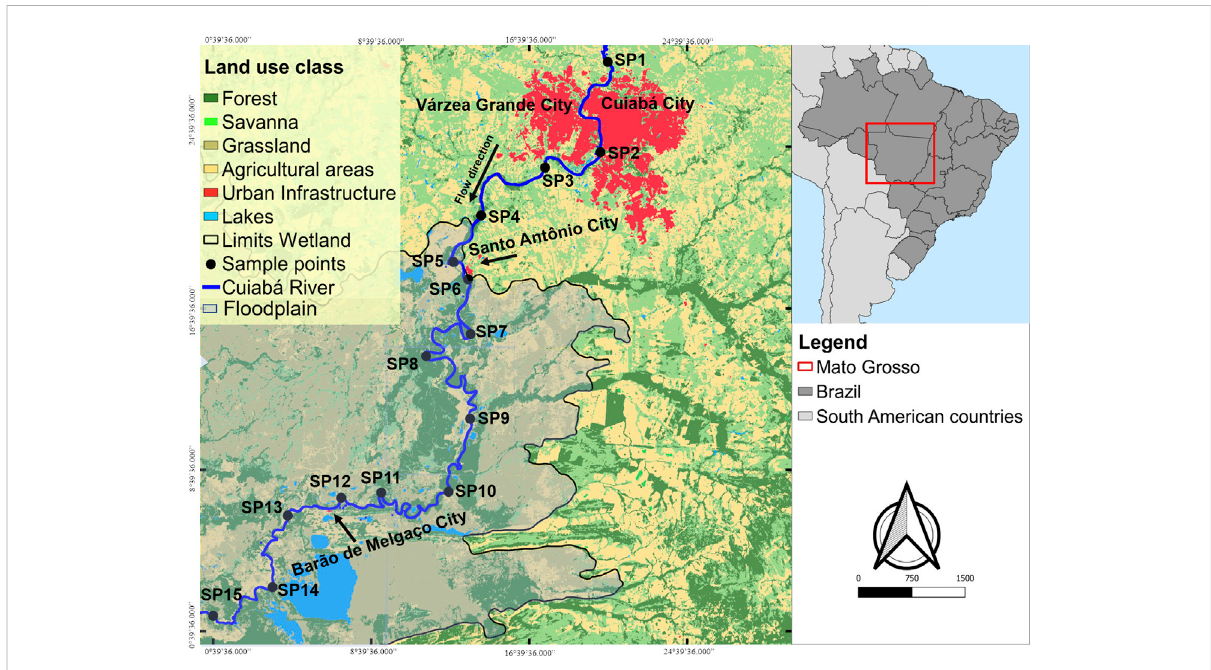
FIGURE 1 Cuiabá River map representing locating sampling sites and the main land use. Sites one to four located on the Plateau highlands and sites 5 – 15 are located on the Pantanal fl oodplain lowlands. The black line delimits the Plateau- Floodplain boundary. The fl oodplain (wetlands) area is shaded and lies at the west of this limit as shown on the map. Cuiabá River fl ows from NE to SW. S p – Sampling